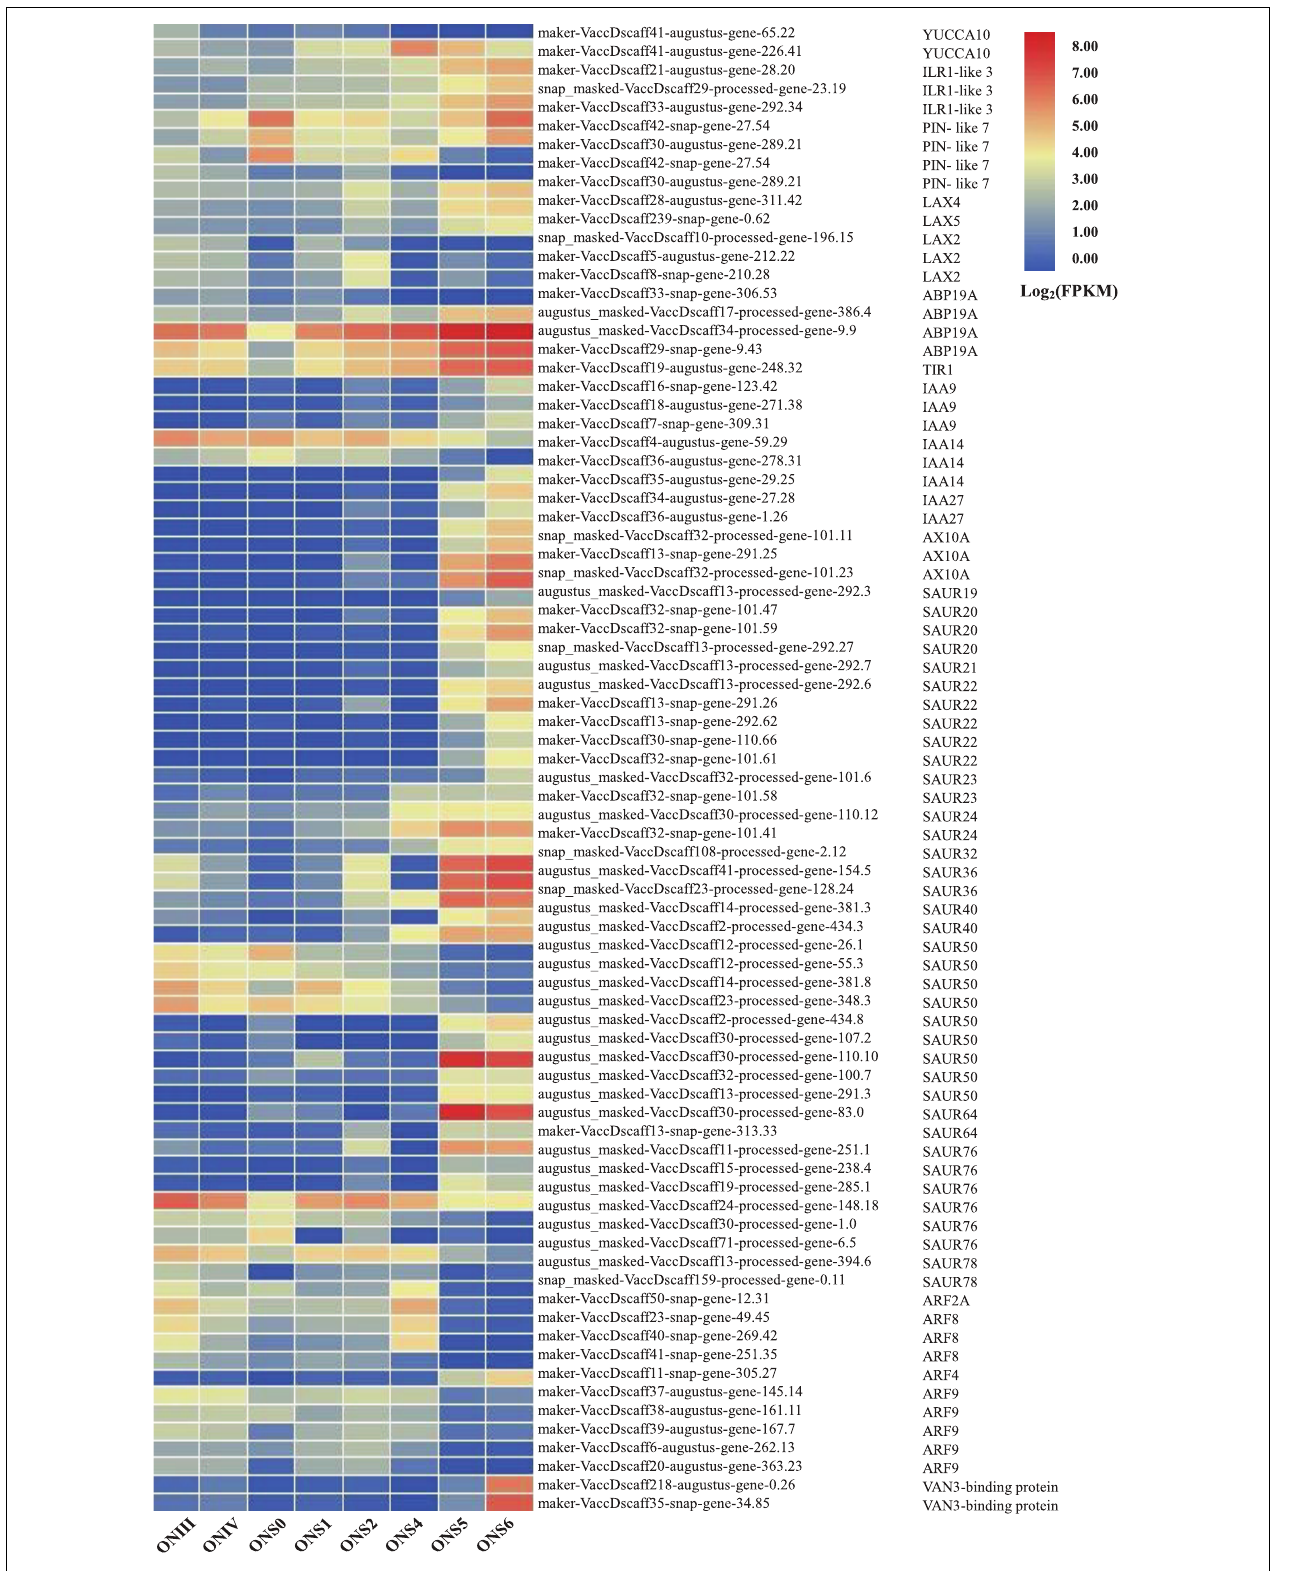
FIGURE 4 | Developmental expression patterns of auxin-related DEGs associated with cell number changes of V. corymbosum ‘O’Neal’ outer mesocarp and columella. Each stage of flower bud and fruit development in ‘O’Neal’ was listed horizontally. The color represented the expression levels (Log 2 FPKM) of DEGs.